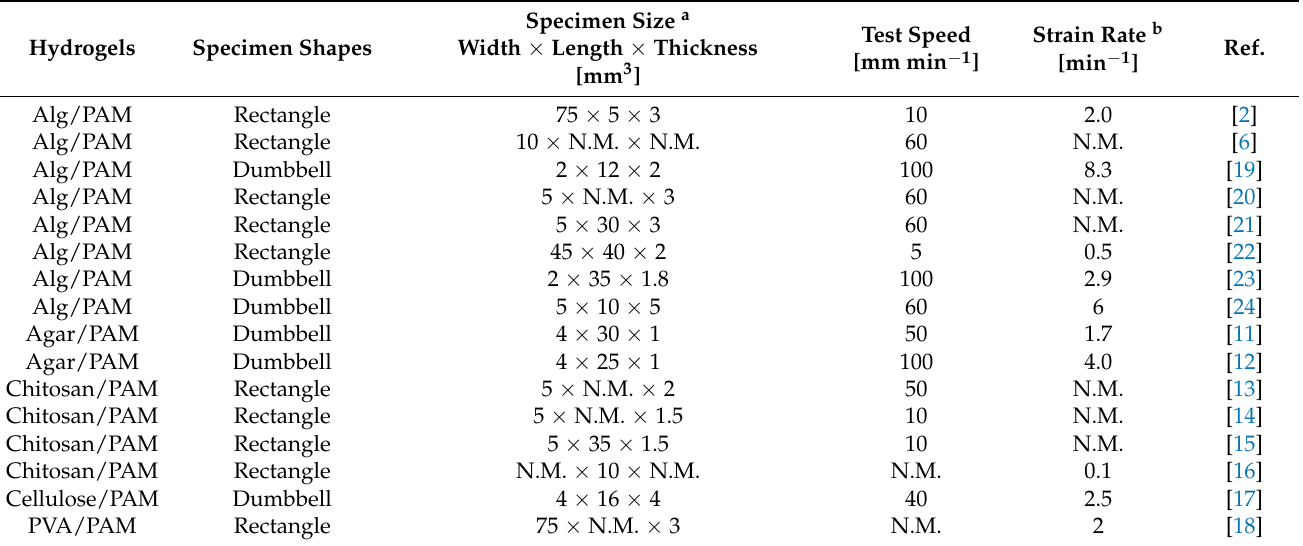
Table 1. Comparison of specimen shapes and sizes, and tensile testing speeds of representative tough hydrogels in the